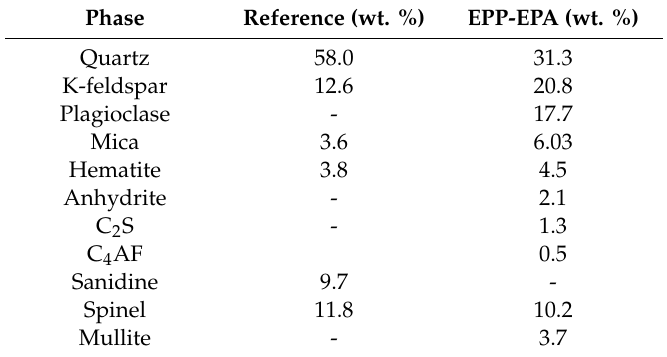
Table 8. Phase composition of Reference and EPP-EPA added bricks (coarse).